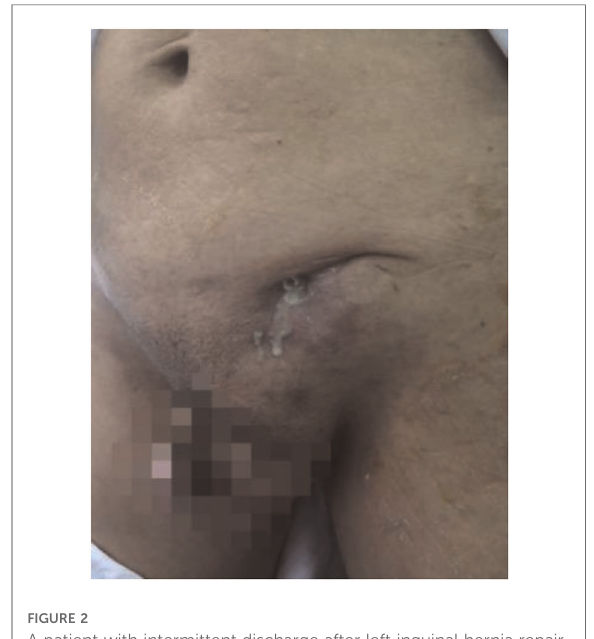
FIGURE 2 A patient with intermittent discharge after left inguinal hernia repair 2 years later.